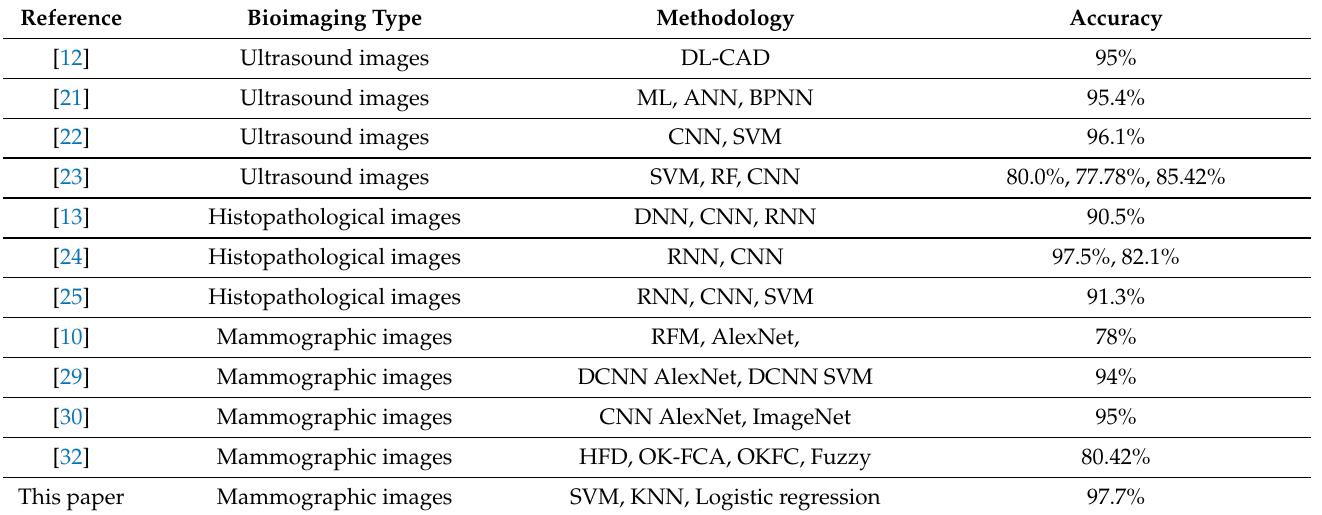
Table 4. Comparison of existing bio-imaging studies.